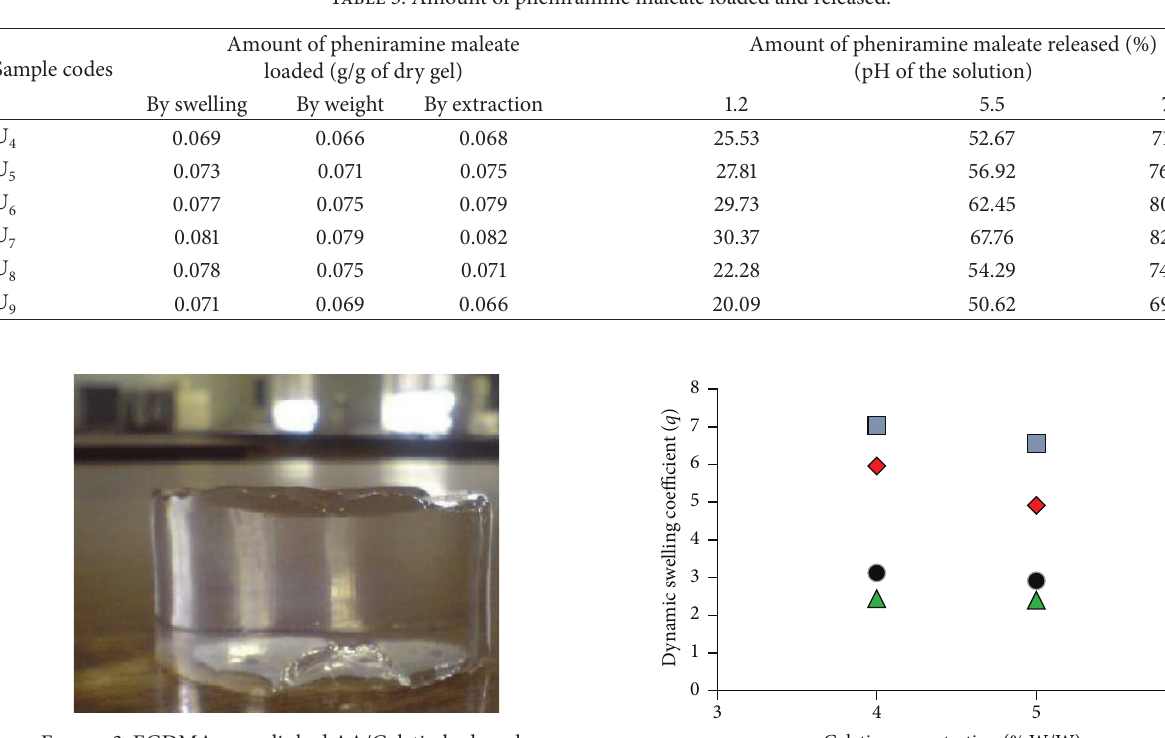
Figure 3: EGDMA cross-linked AA/Gelatin hydrogels.